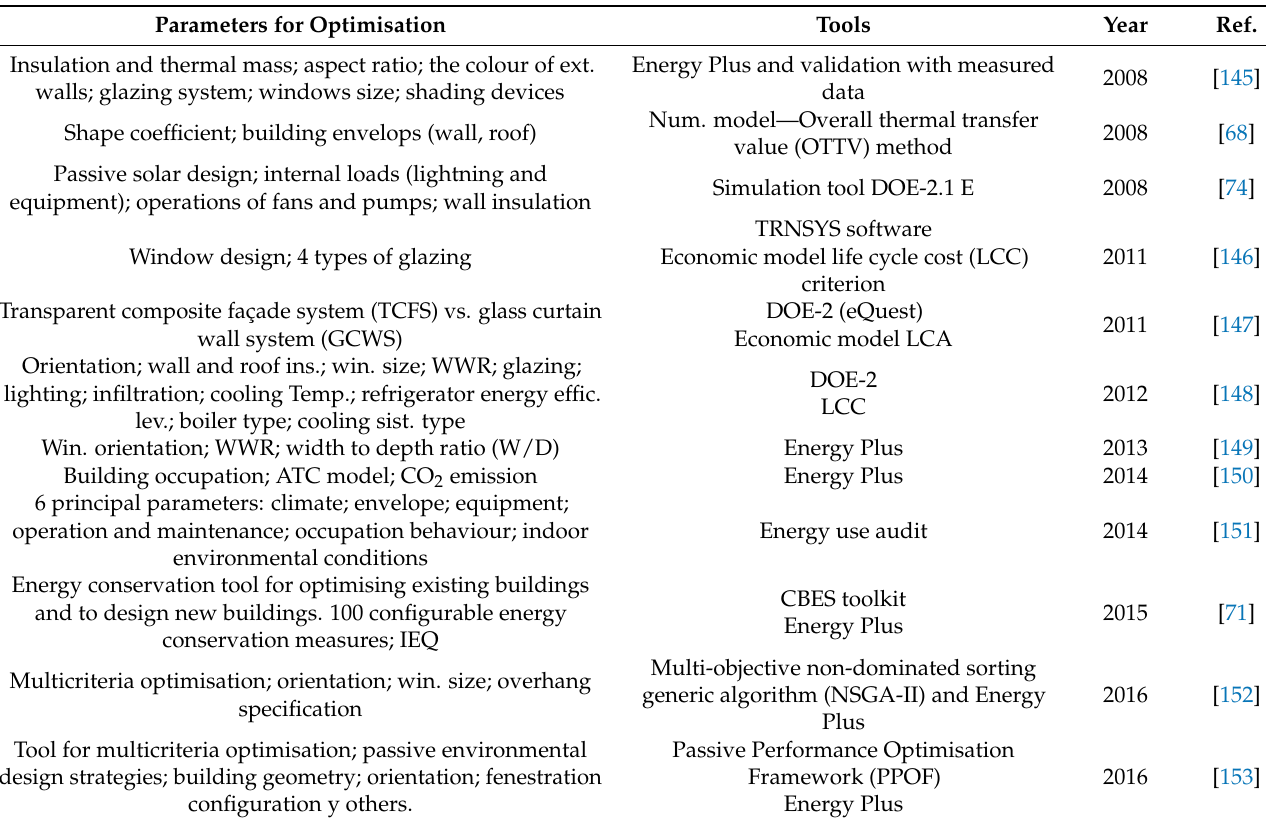
Table 4. Principal studies of the multiparameter